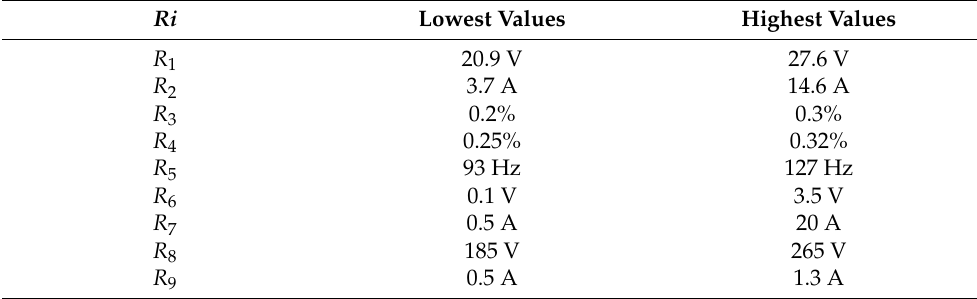
Table 5. Threshold values for R 1 – R 9 .